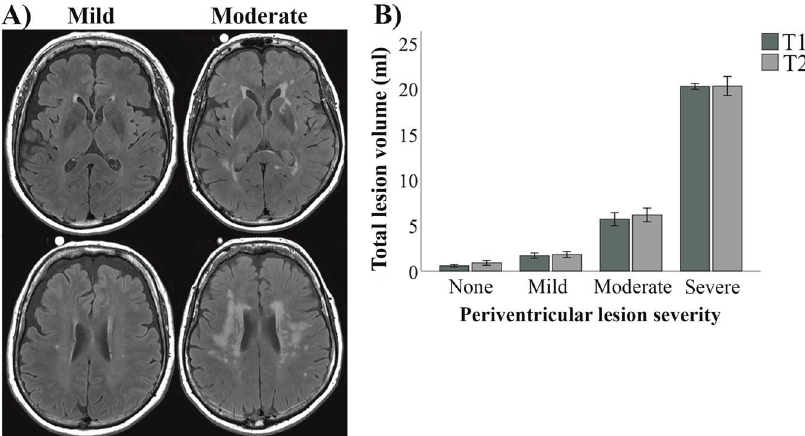
Fig. 1 White-matter lesion severity. Large individual differences in lesion severity was observed in the sample, where the majority had mild (Fazekas grade 1), or moderate (Fazekas grade 2) periventricular lesion severity A . Severity grade was associated with sizeable differences in total lesion volume at the two test occasions B . T1 timepoint 1 - baseline, T2 timepoint 2 -